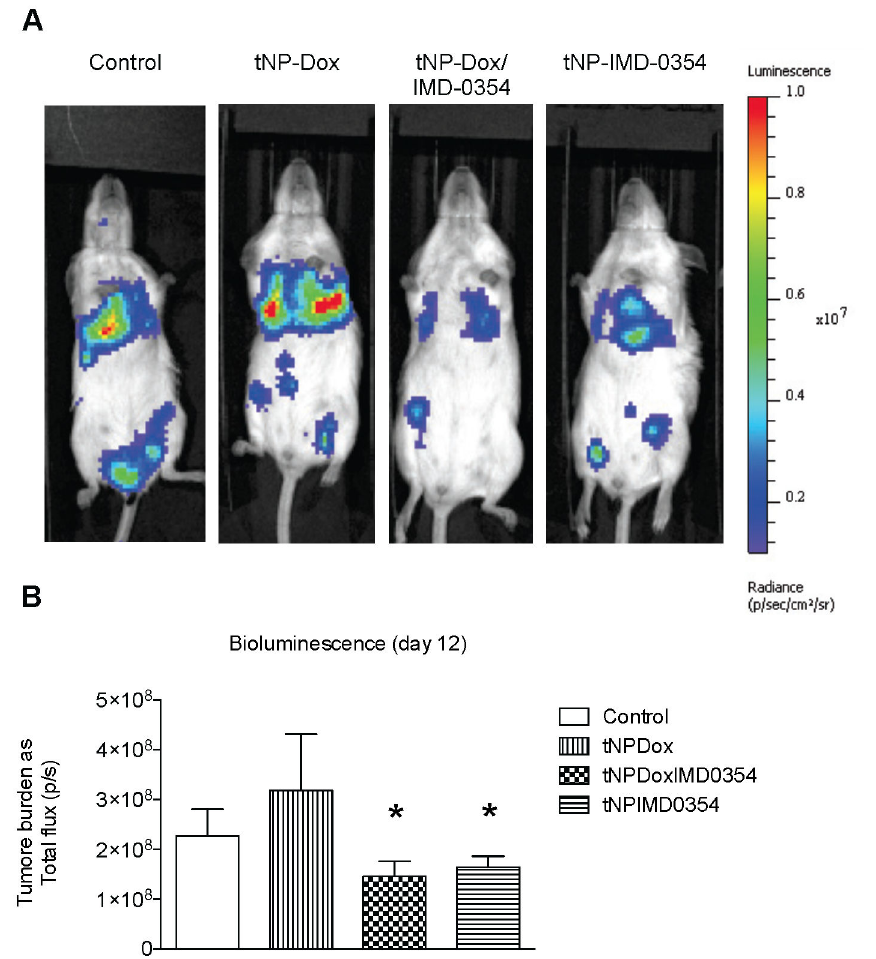
Figure 7. Combination therapy encapsulated into tNPs for drug delivery in vivo . Mice bearing experimental metastatic FL4T1 tumors were treated with tNP-Dox, tNP-IMD-0354 or tNP-Dox-IMD-0354. Tumor burden was detected by in vivo non-invasive imaging of the firefly luciferase expressing FL4T1 cells after intraperitoneal luciferin injection. Tumor bioluminescence intensity was plotted in pseudocolor over black/white photographs (A) and quantified as total flux in photons/seconds (p/s). Data are shown as mean ± SEM. *P-value <